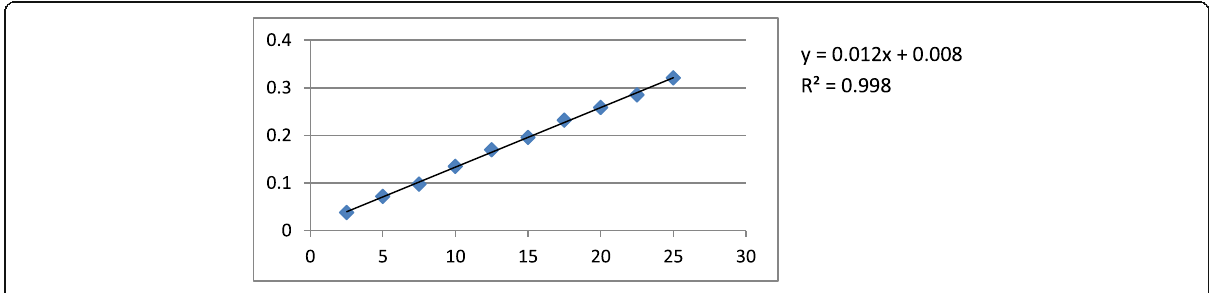
Fig. 7 Standard calibration curve of catechin